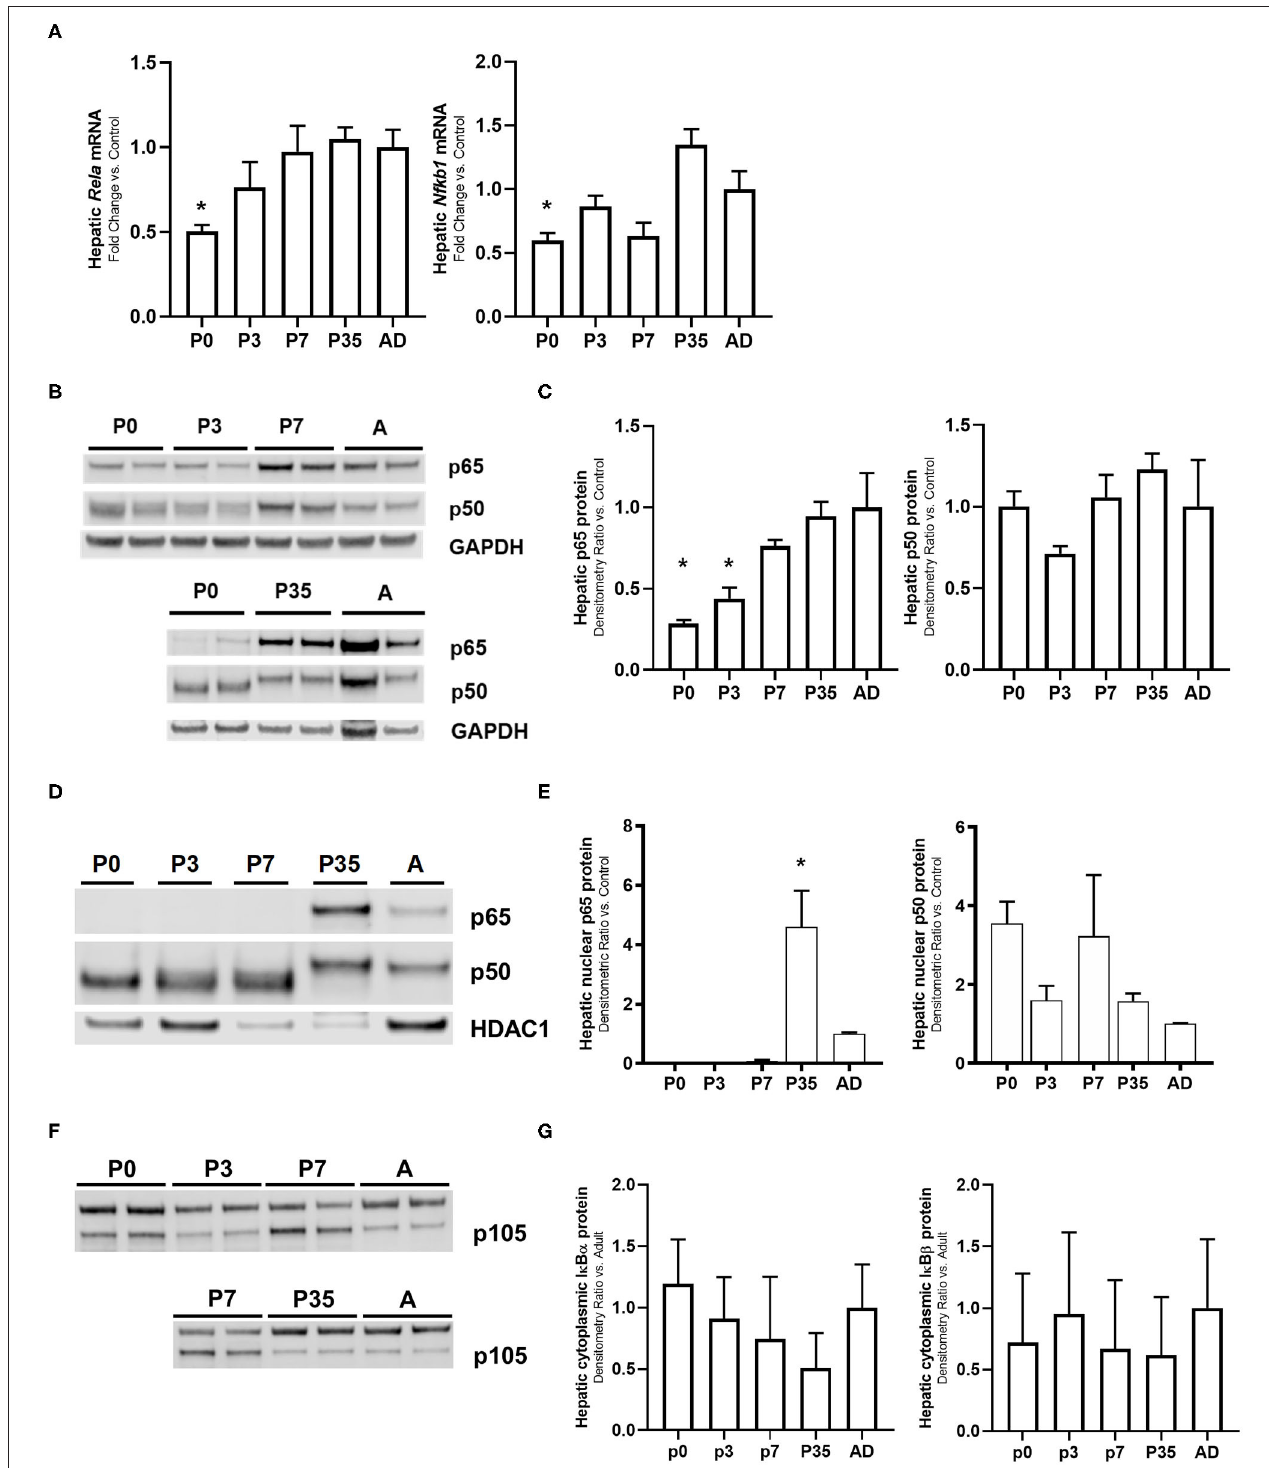
FIGURE 1 | Ontogeny of the NF- κ B subunits shows that p65 protein is developmentally regulated. Unexposed mouse livers from different developmental time points were collected and measured for hepatic (A) cRela and Nfkbl gene expression, (B,C) whole cell lysate and (D,E) nuclear protein p65 and p50 (F) , whole cell lysate protein p105, and (G) cytoplasmic NF- κ B inhibitory proteins I κ B α and I κ B β levels. GAPDH and HDAC1 were used as loading controls for the cytosolic and nuclear extracts, respectively. * P < 0.05 vs. adult (AD) by 1-way ANOVA and Dunnet post-hoc test. Values are represented as fold change relative to adult (AD).